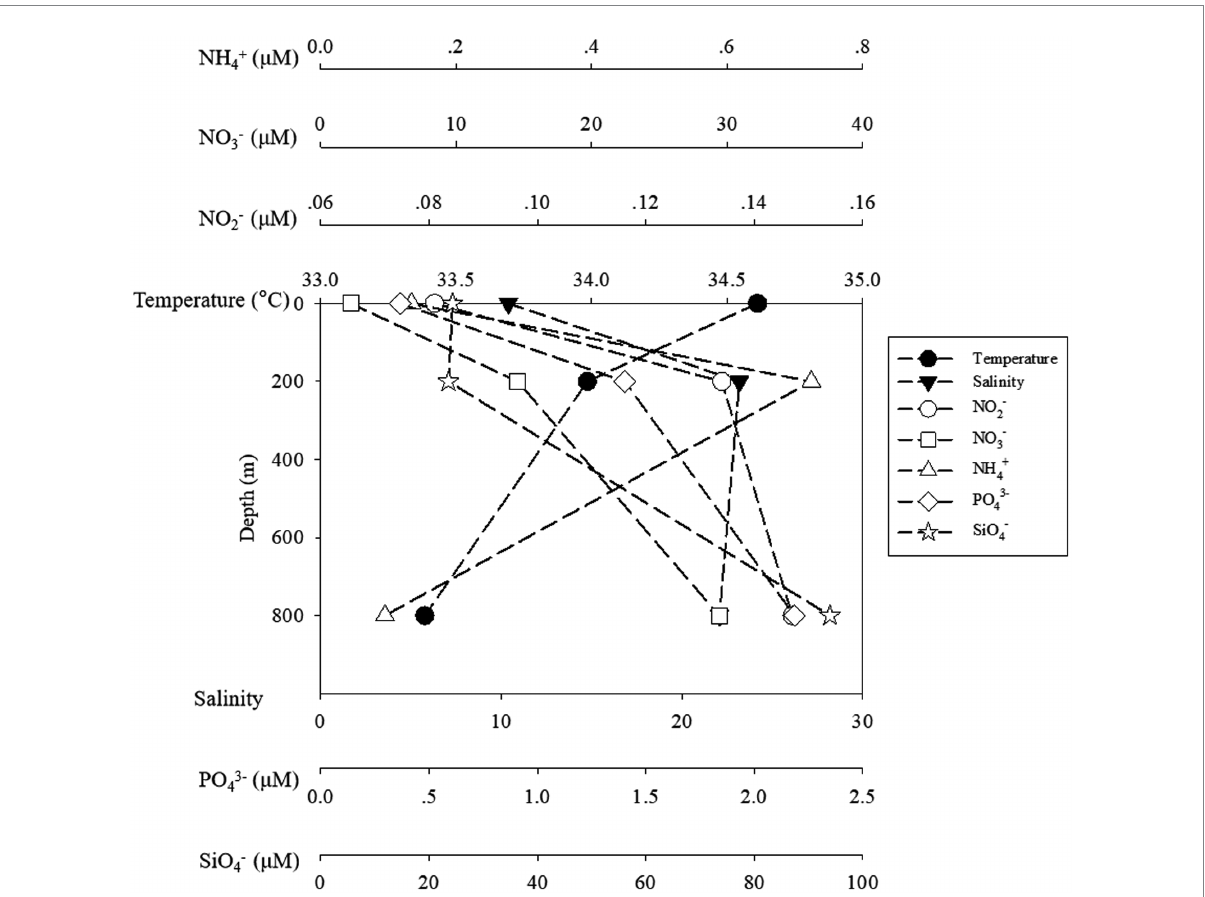
FIGURE 1 The temperature and salinity and inorganic nutrients of ambient water samples. The black symbols of circle, square stand for temperature and salinity, while the blank symbols of circle, square, triangle, diamond and star stand for NO 2 − , NO 3 − , NH 4+ , PO 43 − and SiO 4 − ,